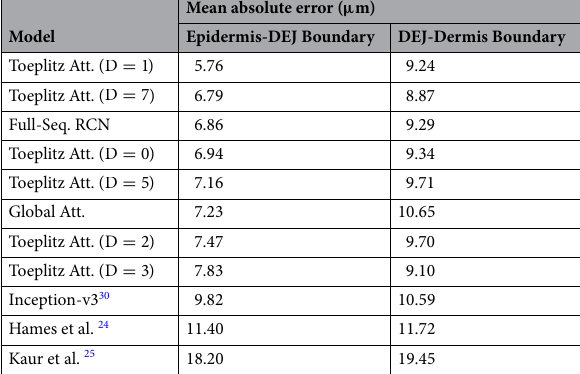
Table 3. Mean absolute error (MAE) of models for estimating epidermis-DEJ and DEJ-dermis boundaries. Models are sorted according to epidermis-DEJ boundary estimation MAE.